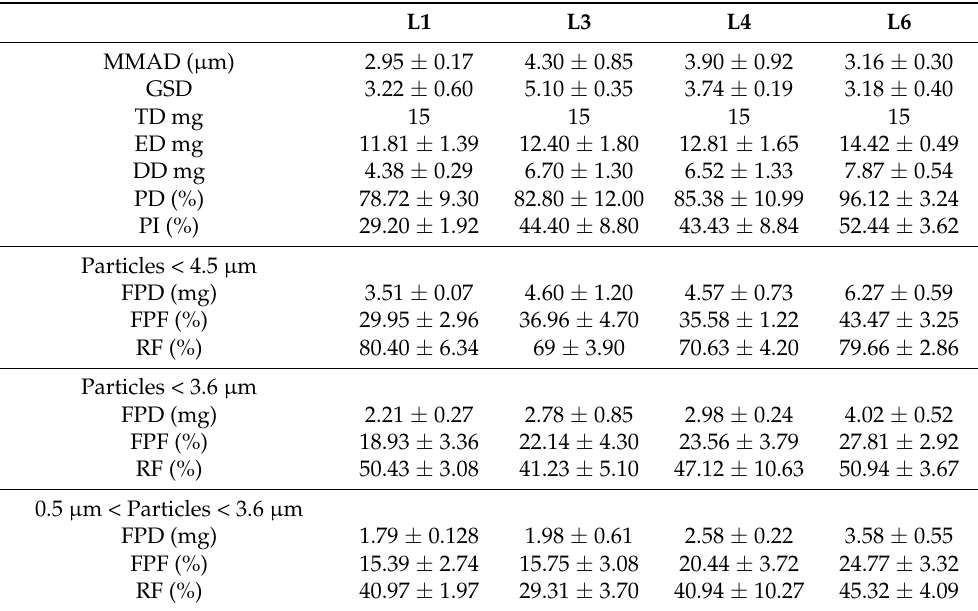
Table 3. Aerosolization and inhalation profiles of chitosan nanoparticles admixed with lactose-PEG microparticles L1, L3, L4 and L6.